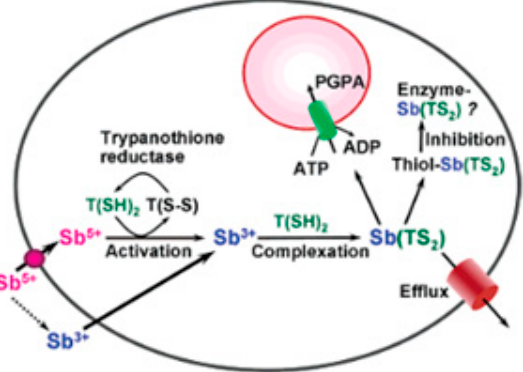
Figure 9. Proposed mechanism of action by various derivatives of antimony based compounds against leishmanial uptake into parasite. Reprinted (adapted) with permission from [80] American Chemical Society (copyright 2019).